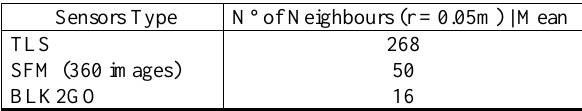
Table 3 . Density analysis: mean deviations from the three scan types.